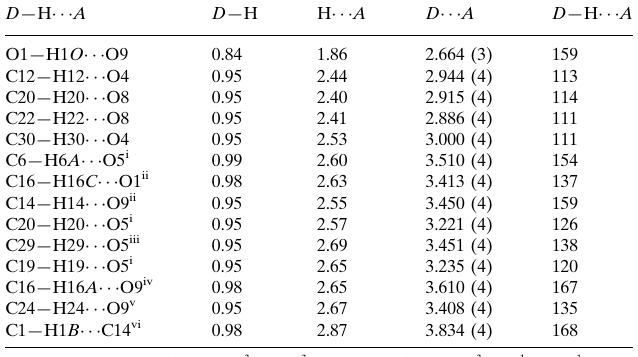
Hydrogen-bond geometry (A˚ , (cid:2)